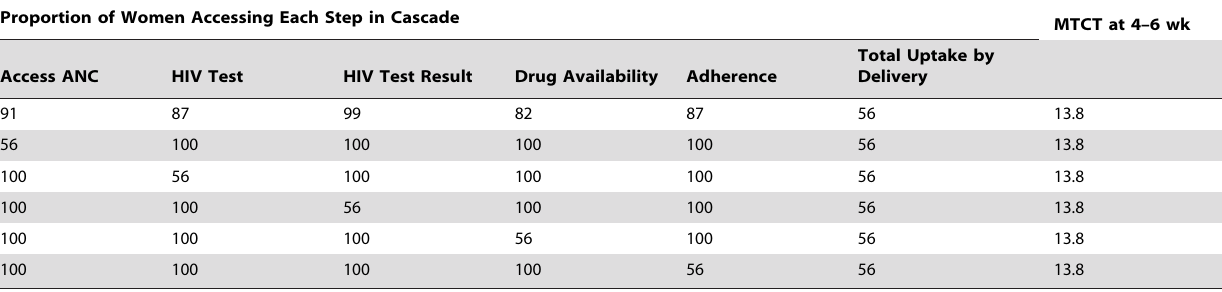
Table 6. Impact of uptake at key antenatal steps in the PMTCT cascade on MTCT at 4–6 wk of age.